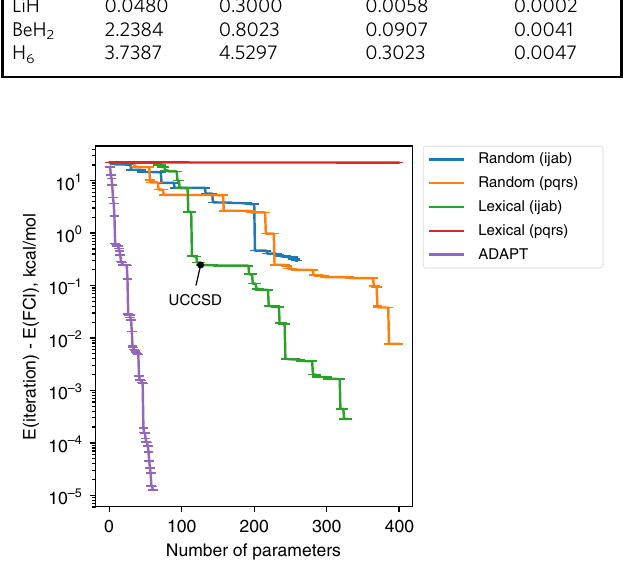
Fig. 3 Convergence of the energy as a function of parameter count for BeH 2 with a Be – H distance of 2.39 Å. The black dot indicates the UCCSD